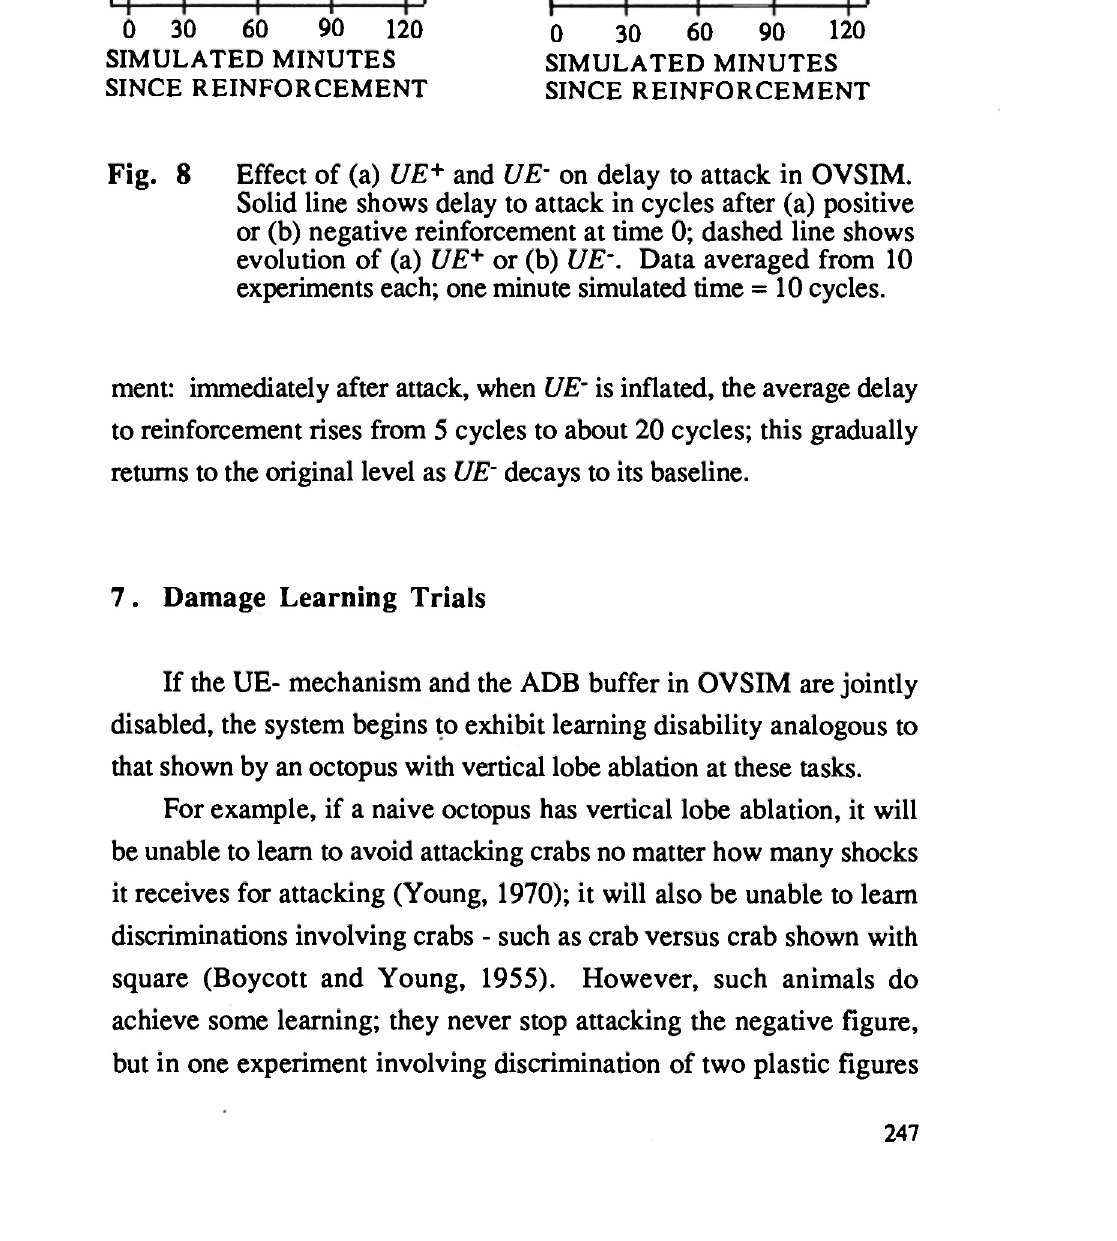
Fig. 8 Effect of (a) UE+ and UE~ on delay to attack in OVSIM. Solid line shows delay to attack in cycles after (a) positive or (b) negative reinforcement at time 0; dashed line shows evolution of (a) UE + or (b) UE\ Data averaged from 10 experiments each; one minute simulated time = 10